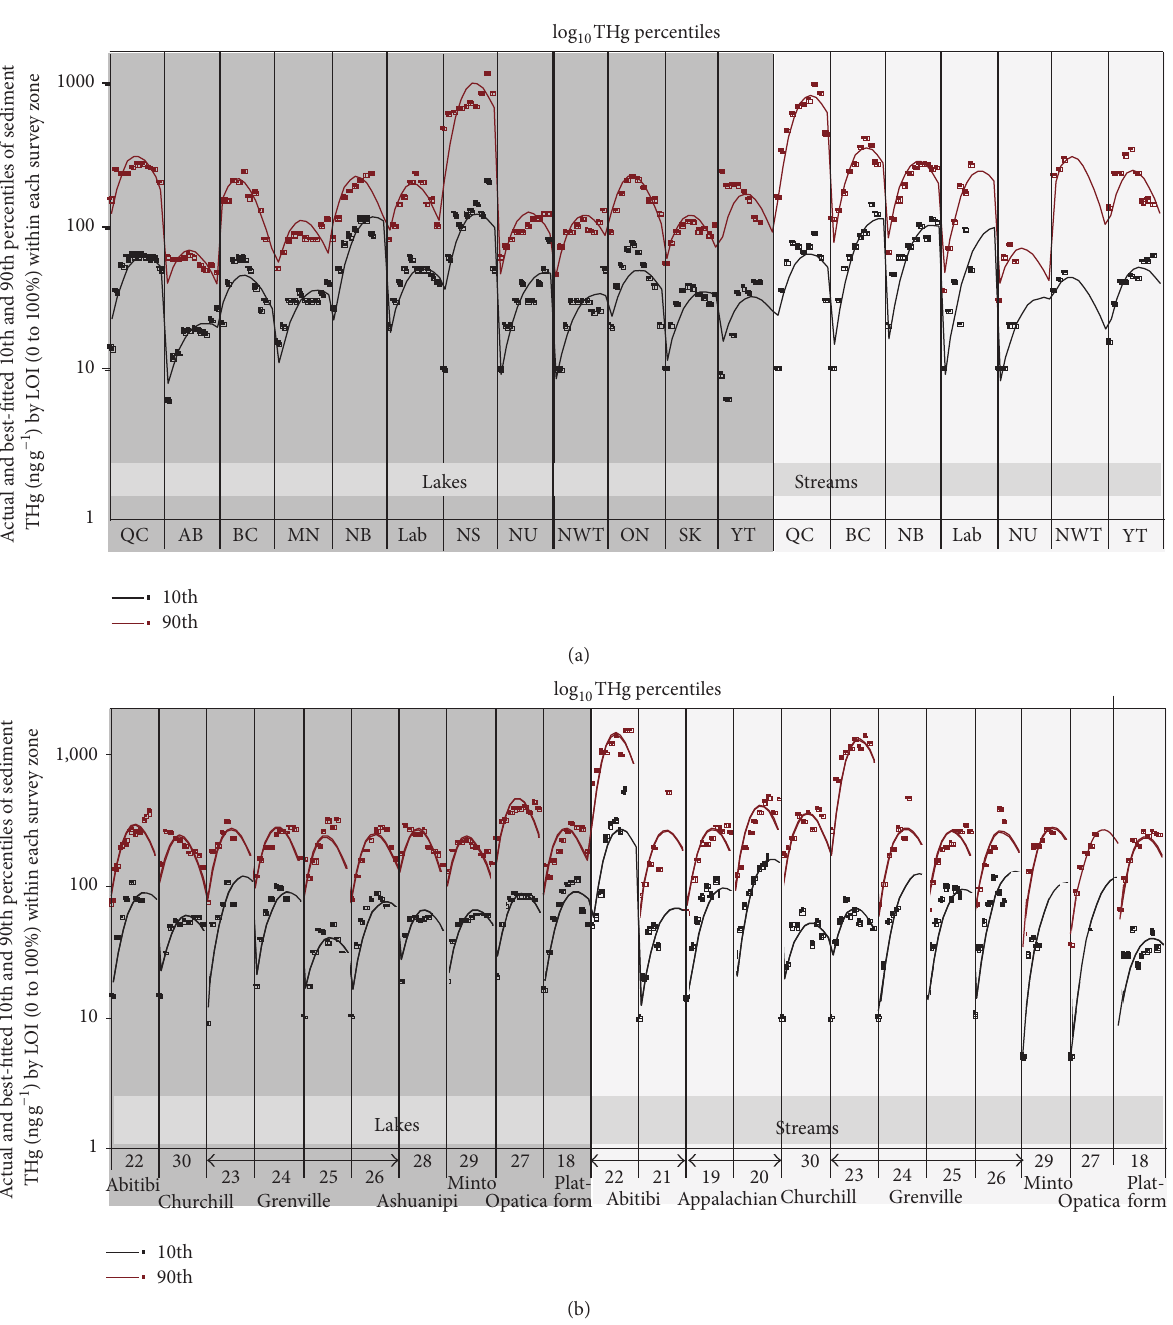
Figure 9: Plots of actual (dots) versus best-fitted 10th and 90th percentiles using (1) (lines) for lake and stream sediment log 10 THg (ngg −1 , log 10 scale) versus 0 < LOI < 100%, by provinces/territories (a) and Quebec survey zones ((b) Figure